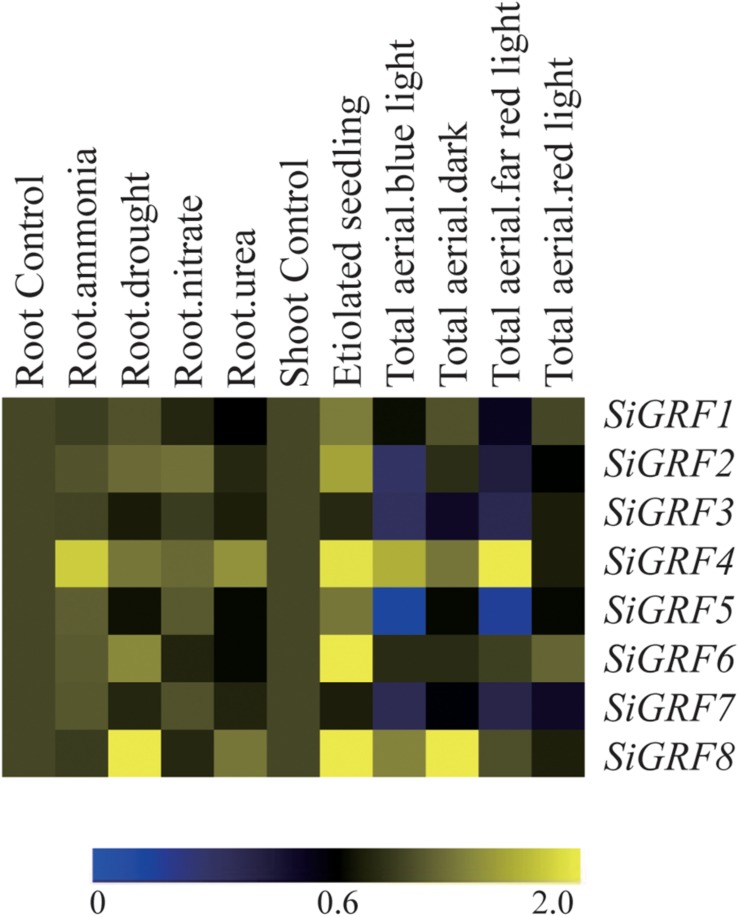
Expression profiles of SiGRF genes differentially expressed under stress and light conditions. The values of SiGRF genes under the control (untreated) and various stress conditions (labeled at the top of each lane) are presented by cluster display. The color scale representing signal values is shown at the bottom.